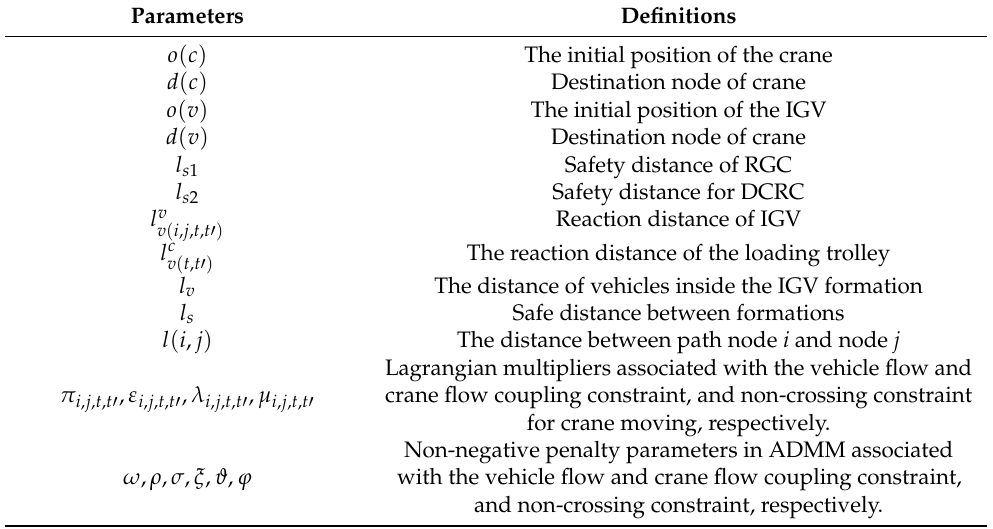
Table 2. Parameters for the model